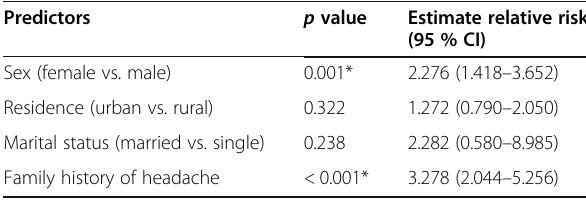
Table 5 Predictors of migraine headache among the medical students under study Predictors p value